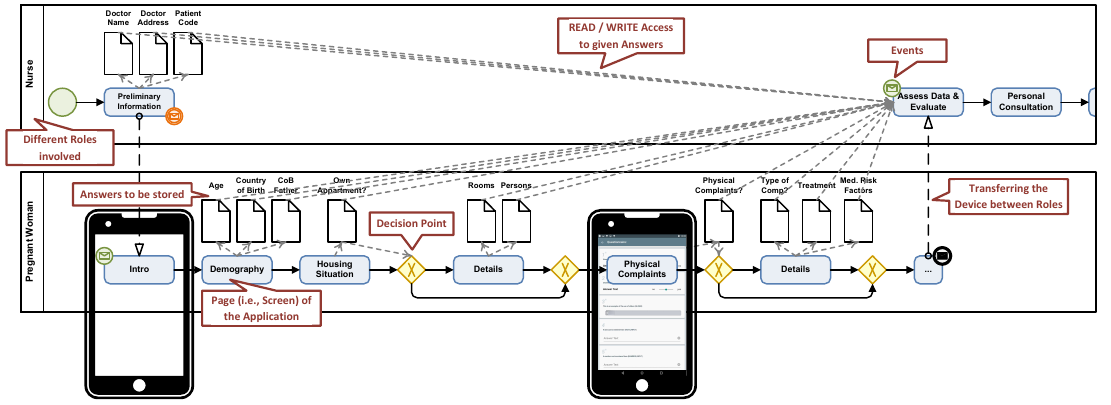
Figure 1. A data collection instrument represented as BPMN (Business Process Model and